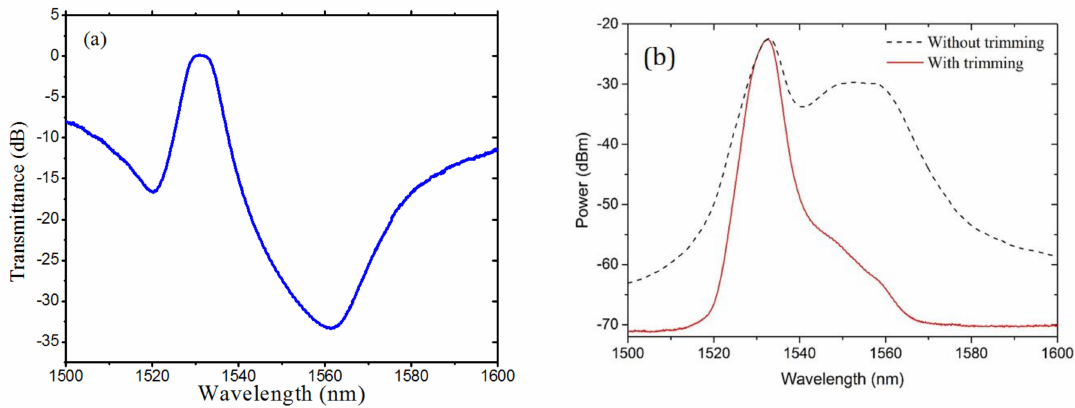
Figure 7. ( a ) Transmission spectrum of custom filter and ( b ) original spectrum and actual trimming spectrum.